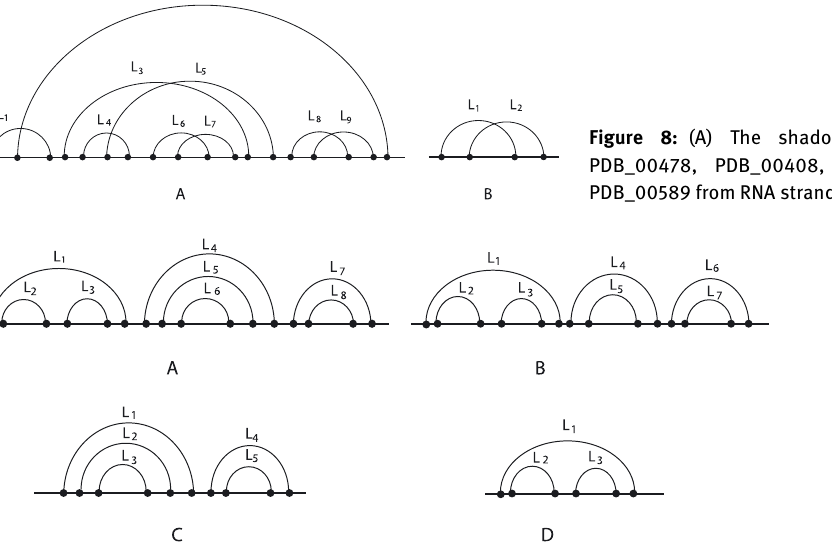
Figure 8: (A) The shadow of molecules with ID